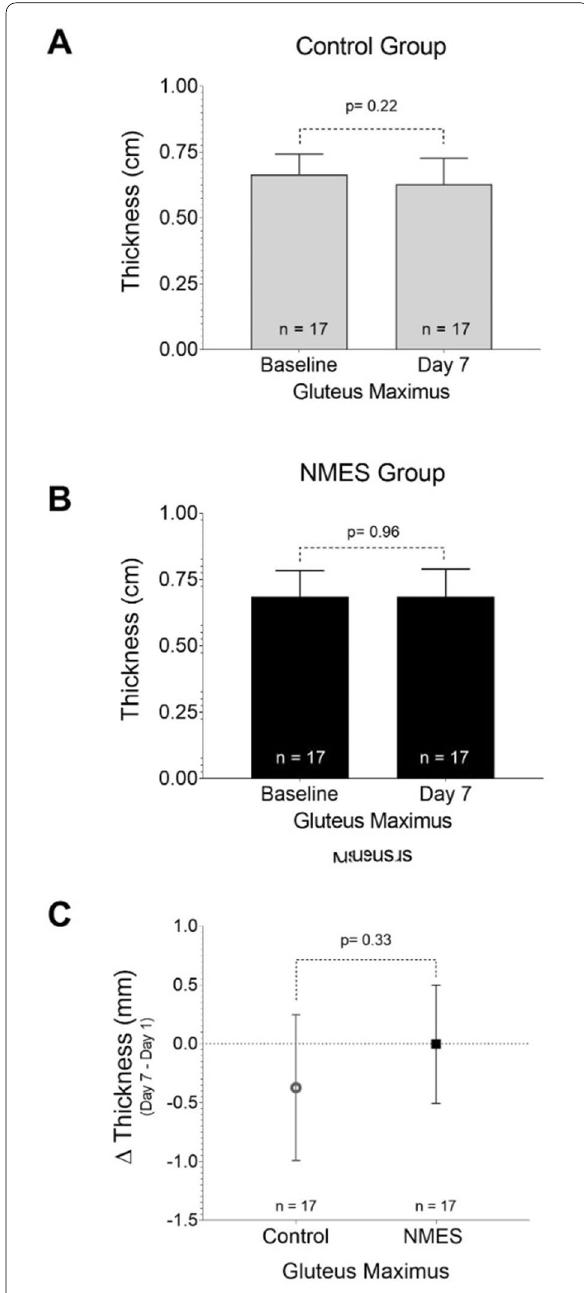
Fig. 6 Comparison of intragroups and intergroups gluteus maximum muscle thickness. Only 17 patients remained in the ICU for at least 7 days. NMES: neuromuscular electrical stimulation. p values were calculated by the Student’s t